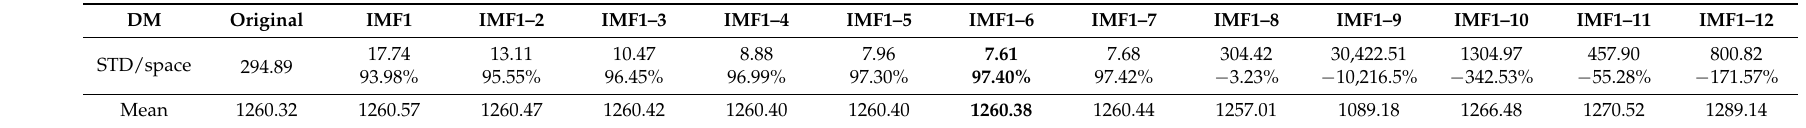
Table 2. Statistics of the mean standard deviation (STD) and the mean grayscale value in the spatial variation for digital mode test imagery before and after the correction of the sensor. The lowest mean STDs are marked with boldface; percentage numbers indicate the improvement ratio compared with the original STD. DM stands for digital mode sensor; x is the number of accumulative IMFs; IMF1– x stands for the sum of x IMFs deducted from the original grayscale values. STD/space denotes the STD calculated after the space variation calibration.